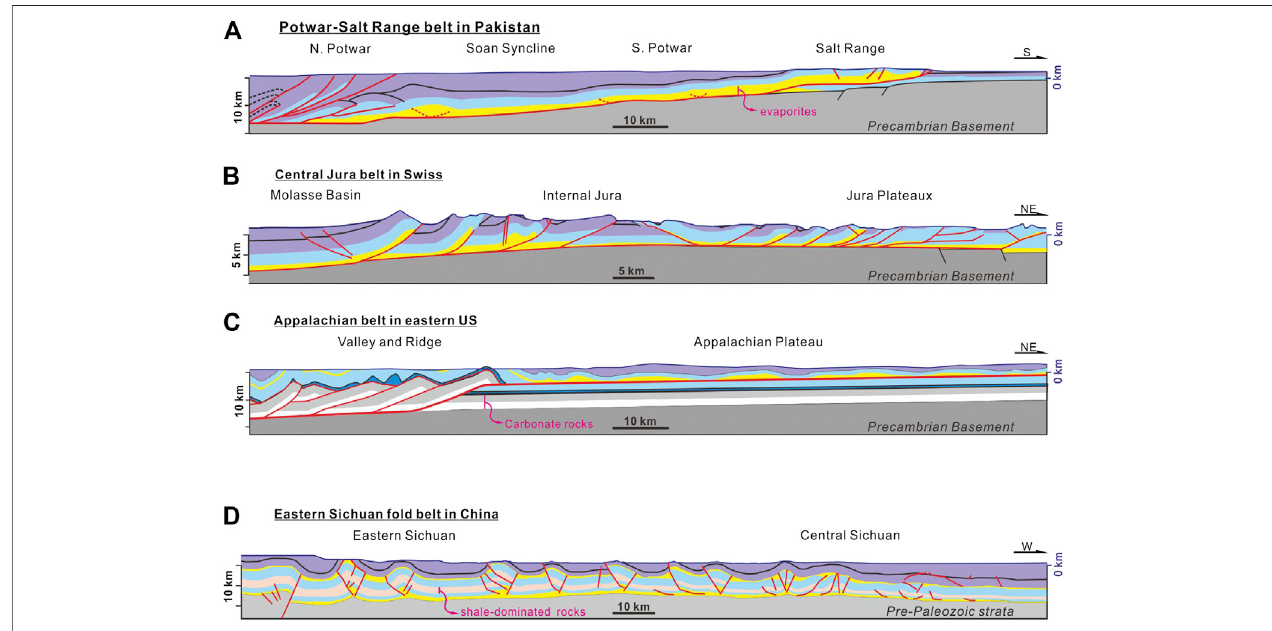
FIGURE 10 | Typical cross sections of (A) The Patowar-Salt Rangle FTB in Pakistan (after Jaumé and Lillie, 1988); (B) The central Jura belt in Swiss (Affolter and Gratier, 2004); (C) The central Appalachian FTB in Pennsylvania, eastern United States (Sak et al., 2012); (D) The eastern Sichuan fold belt in China (Gu et al., 2021); Yellow color indicates the involved salt (evaporites) décollements. Other colors are used to show deformation only, not represent specail strata unless being labbed.